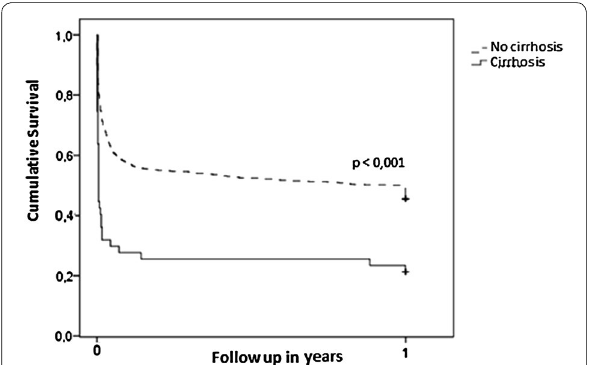
Fig. 1 Survival after ICU admission for cardiac arrest according to the presence and absence of cirrhosis estimated by